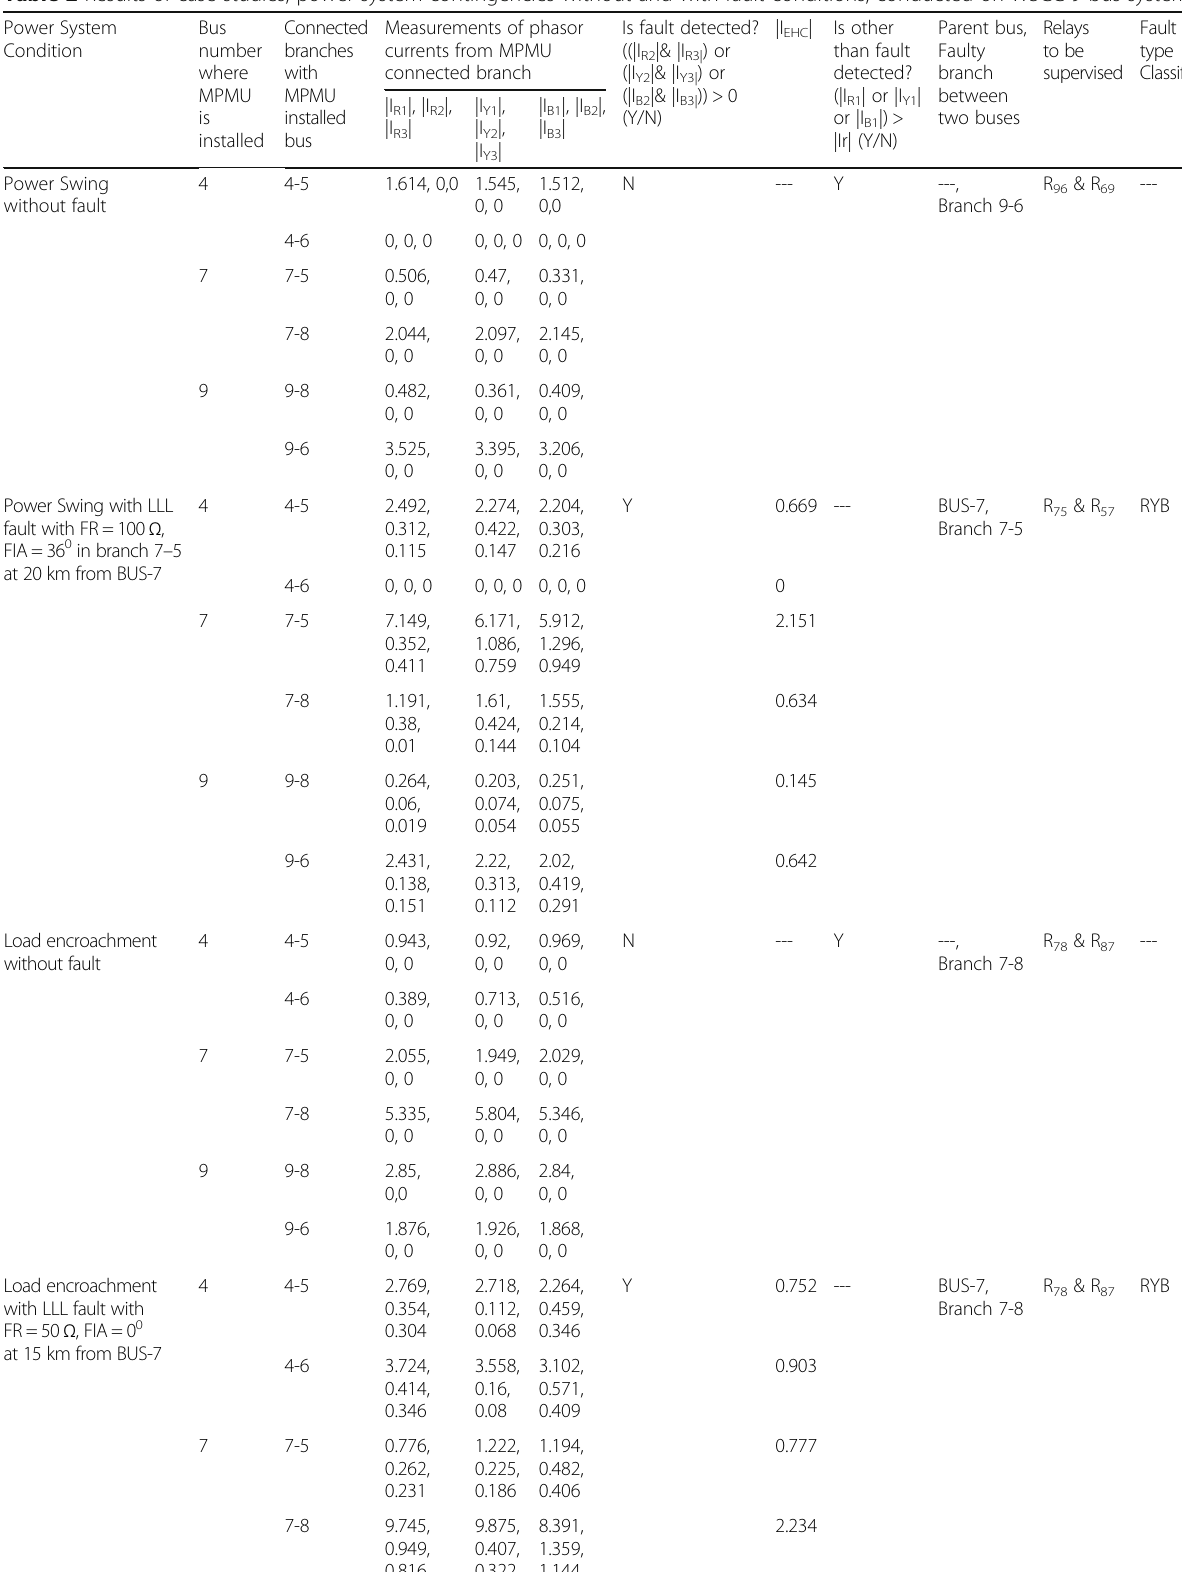
Table 2 Results of case studies, power system contingencies without and with fault conditions, conducted on WSCC-9 bus system Power System